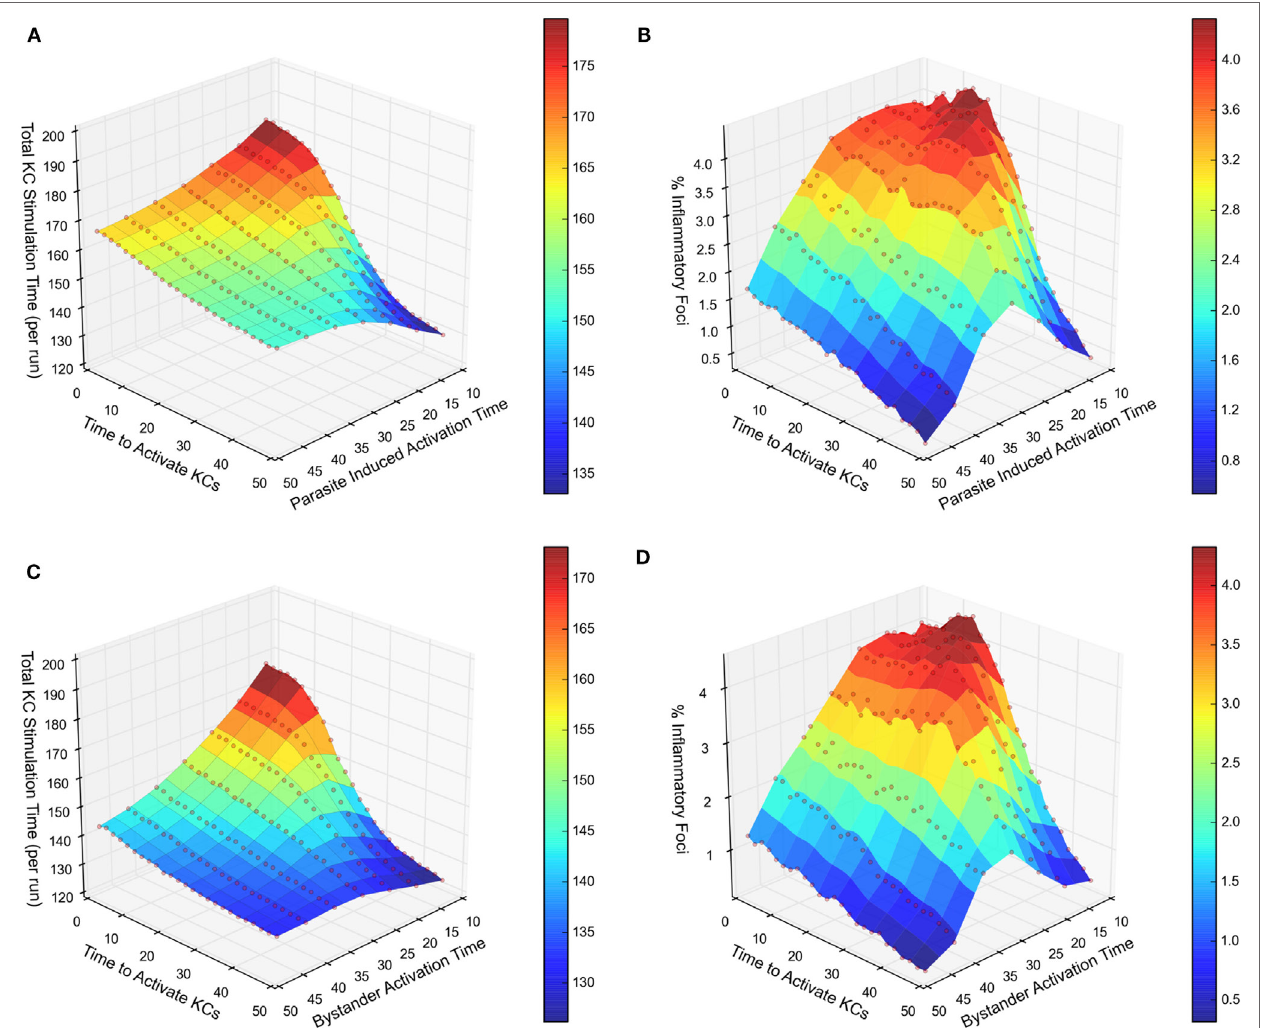
FigUre 3 | Response landscapes for parasite-induced KC activation with and without KC activation in trans. (a–D) Two-at-a-time (TAT) parameter analysis showing the effect on total KC stimulation time (a,c) and on % inflammatory foci (B,D) of modifying either cumulative time to activate KCs and parasite-induced activation time (a,B) or cumulative time to activate KCs and bystander activation time (c,D) . For further details, see Supplementary Experimental